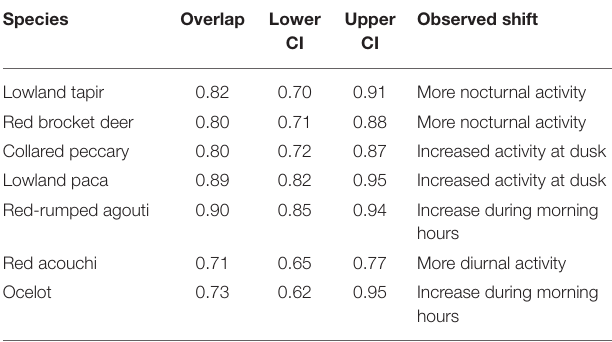
TABLE 5 | Percent overlap and overall trends in activity patterns of species of interest between Site 2 (very low hunting intensity) and Site 4 (high hunting